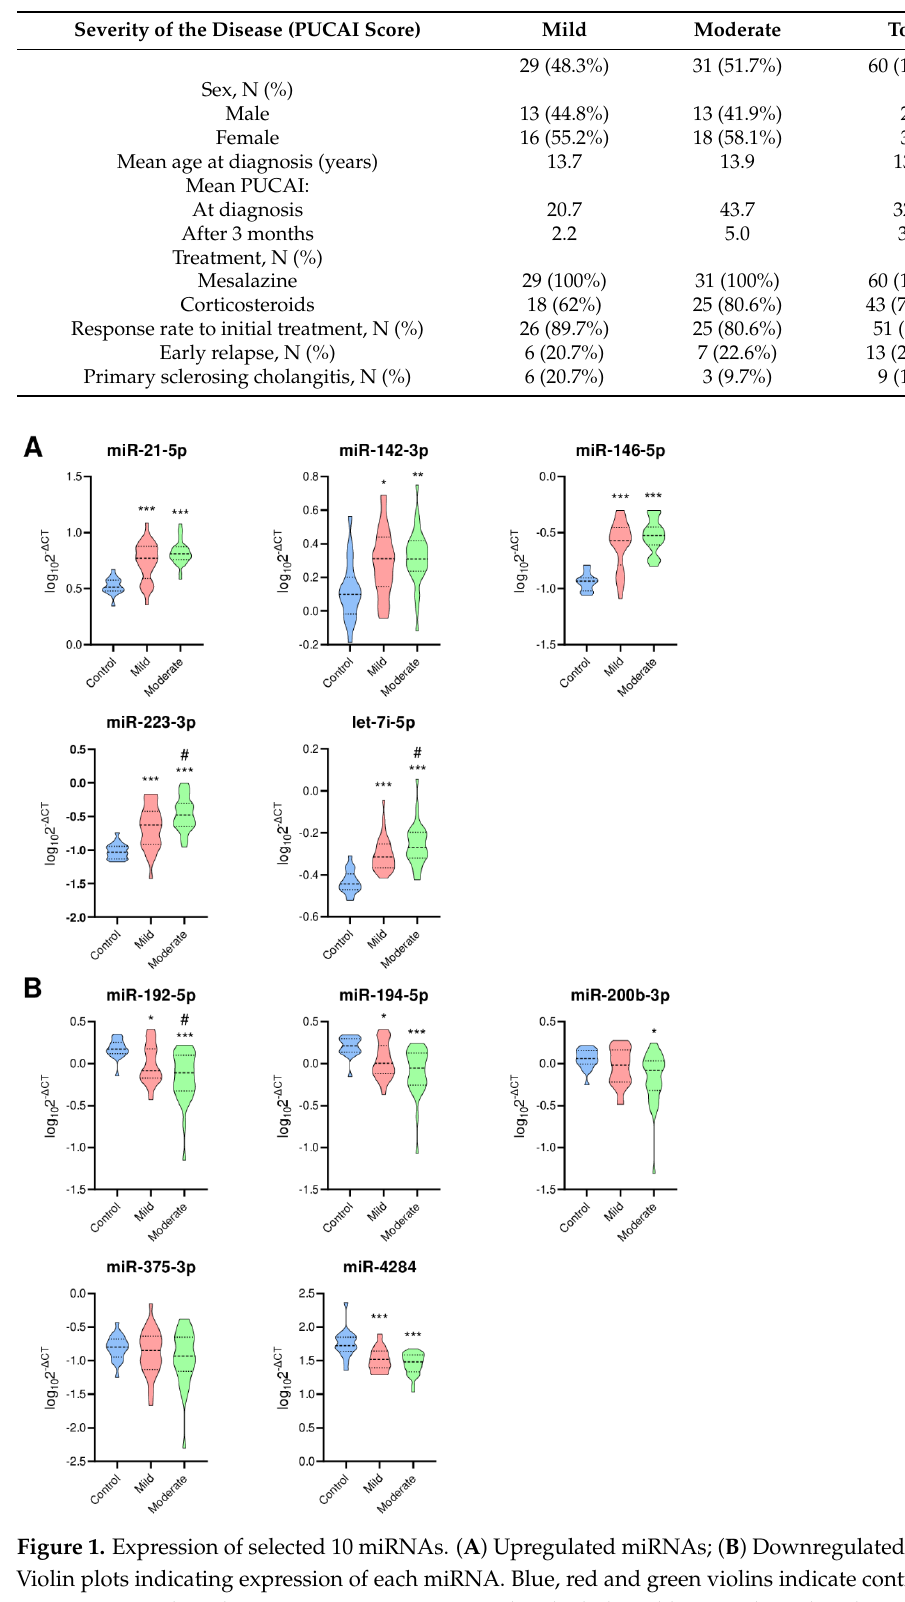
Table 1. Demografic and clinical characteristics of UC patients.